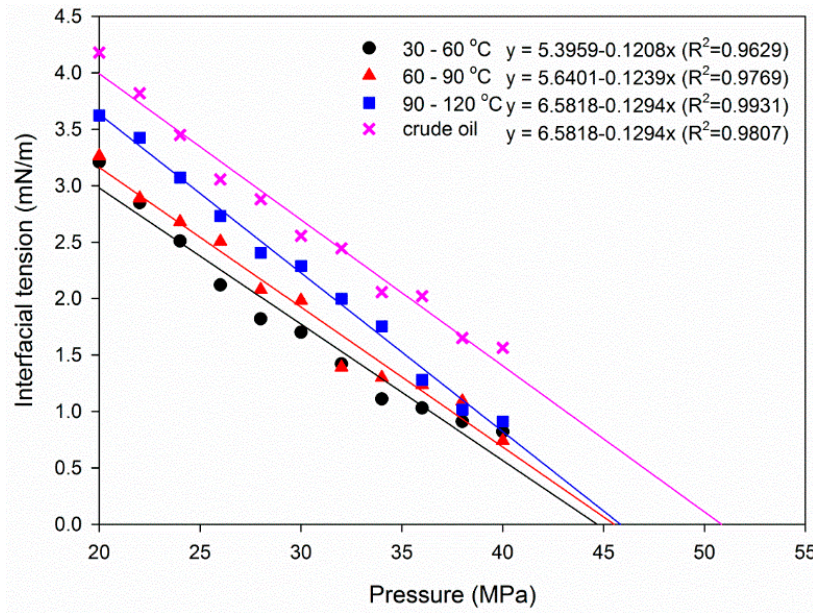
Figure 10. Changes of CO 2 –oil IFTs with pressures for the crude oil diluted with different petroleum ethers.